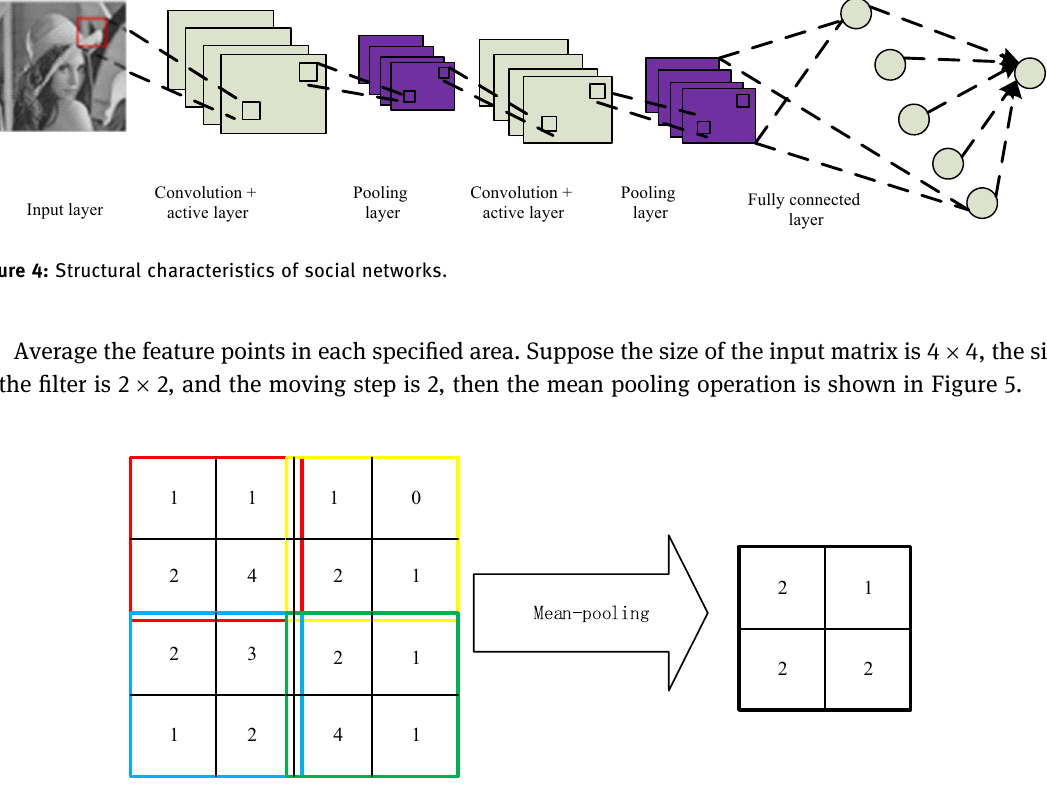
Figure 5: Image denoising average pooling